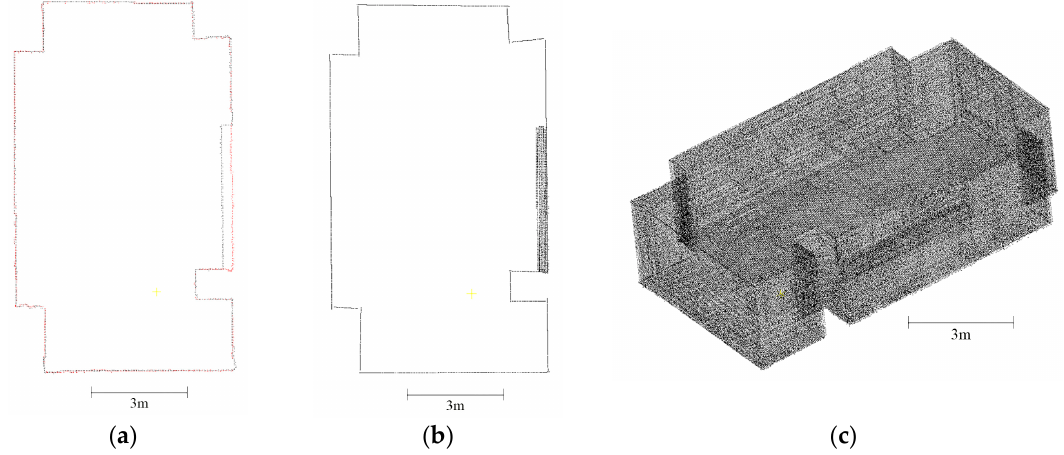
Figure 7. Model-driven refinement of structural elements: ( a ) the boundary point of ceiling segment (points in black color) and floor segment (points in red color) after projection, ( b ) top view of wall segment after refinement, ( c ) all points of structural elements after refinement.